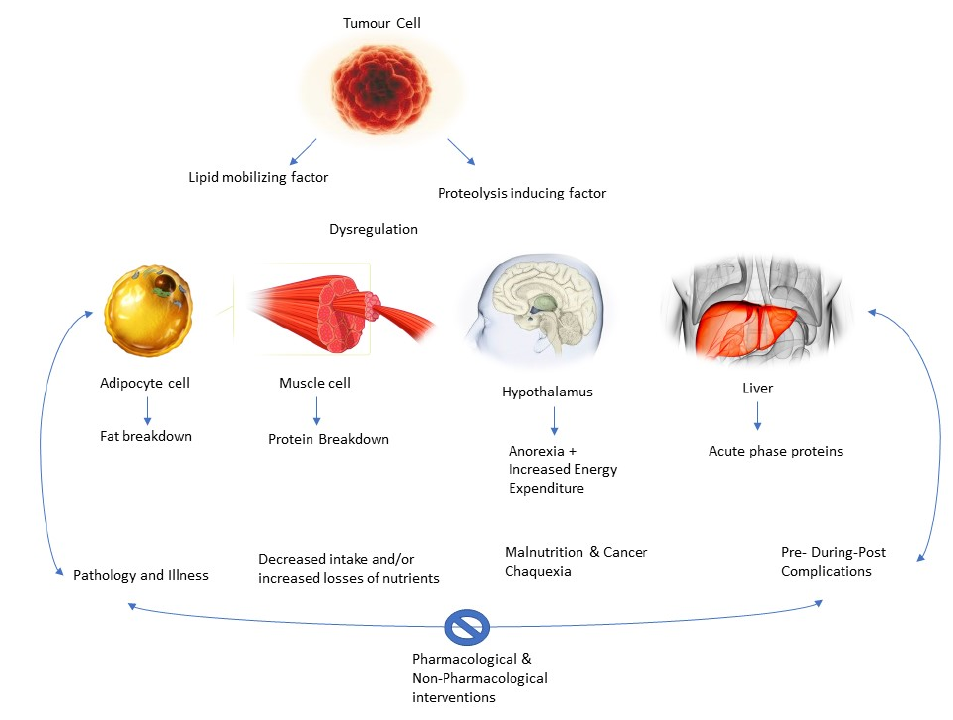
Figure 4. Role of pharmacological and non-pharmacological interventions.